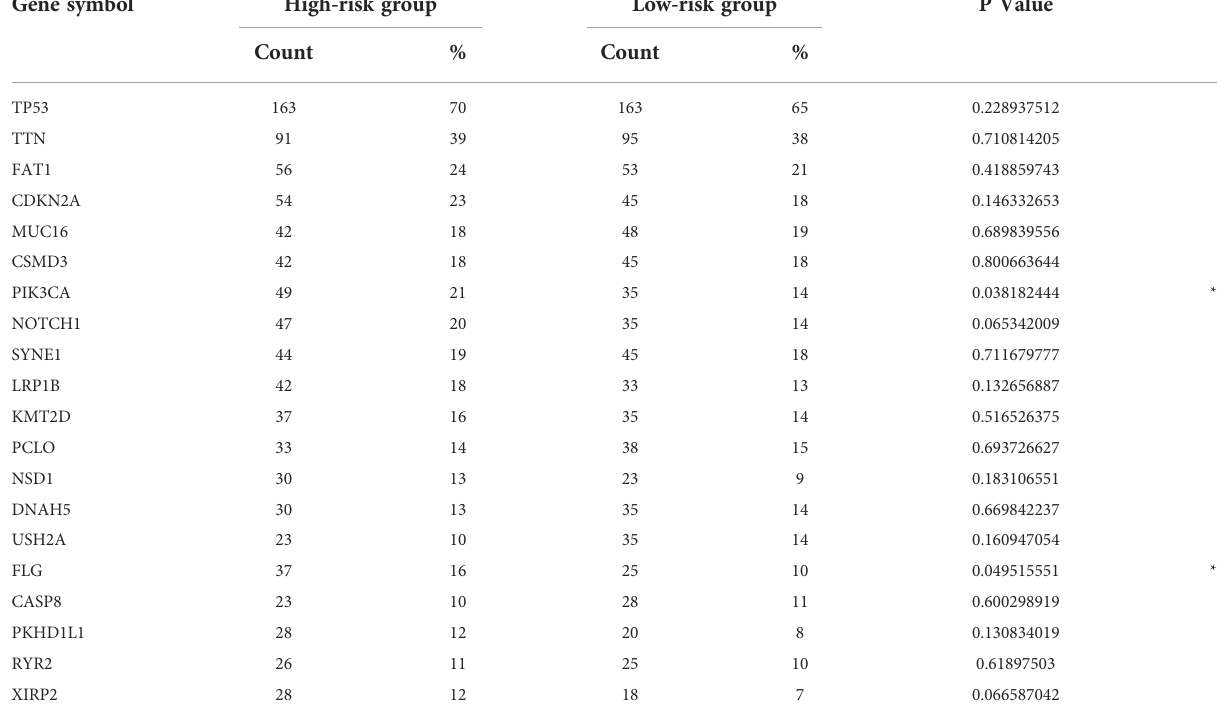
TABLE 2 Differences in mutated genes between high and low risk groups. Gene symbol High-risk